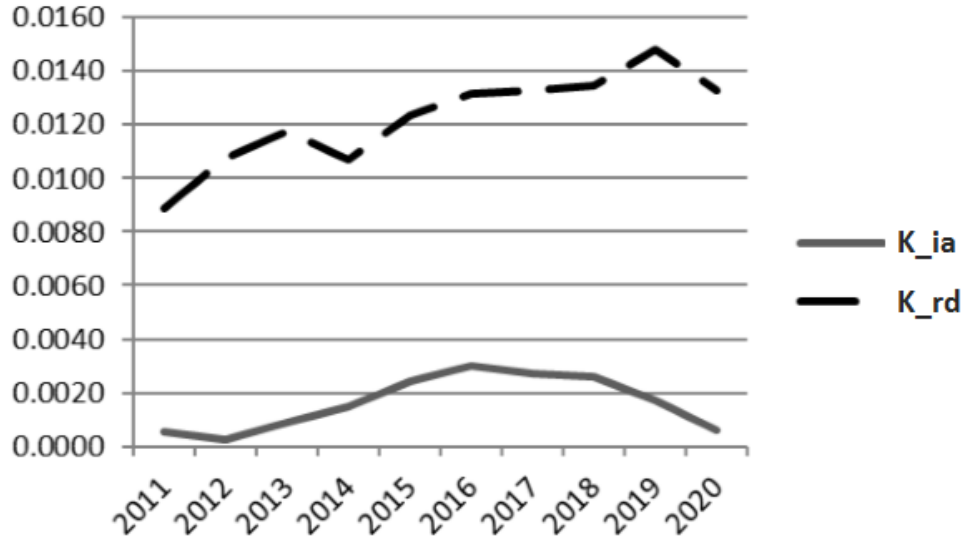
Figure 17. Coefficients of the intangible assets (K_ia) and R&D costs (K_rd) for Boliden AB.